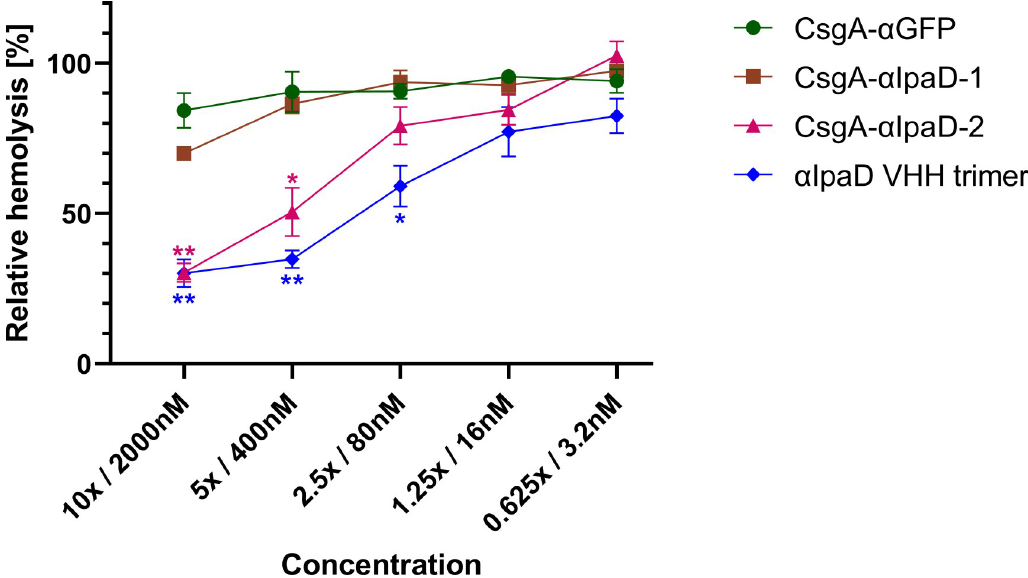
Fig 6. CsgA-VHHs can neutralize S . flexneri contact-mediated hemolysis. PBP8 expressing CsgA- α IpaD-2, but not CsgA- α IpaD-1, inhibited hemolysis of sheep red blood cells, significantly outperforming the off-target negative control (CsgA- α GFP). Data presented as mean ± SEM. Two-way ANOVA (P < 0.0001) was performed to test the presence of difference between conditions, P-values calculated by Welch’s t-test. � P < 0.05; �� P < 0.01.